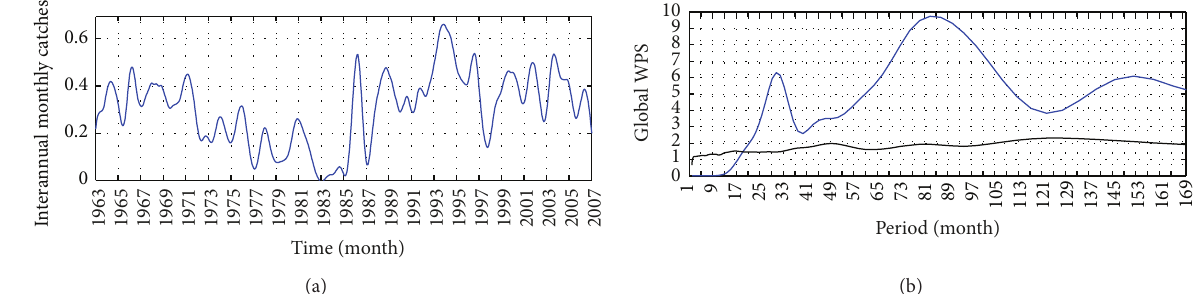
Figure 4: (a) Interannual ( 𝑥